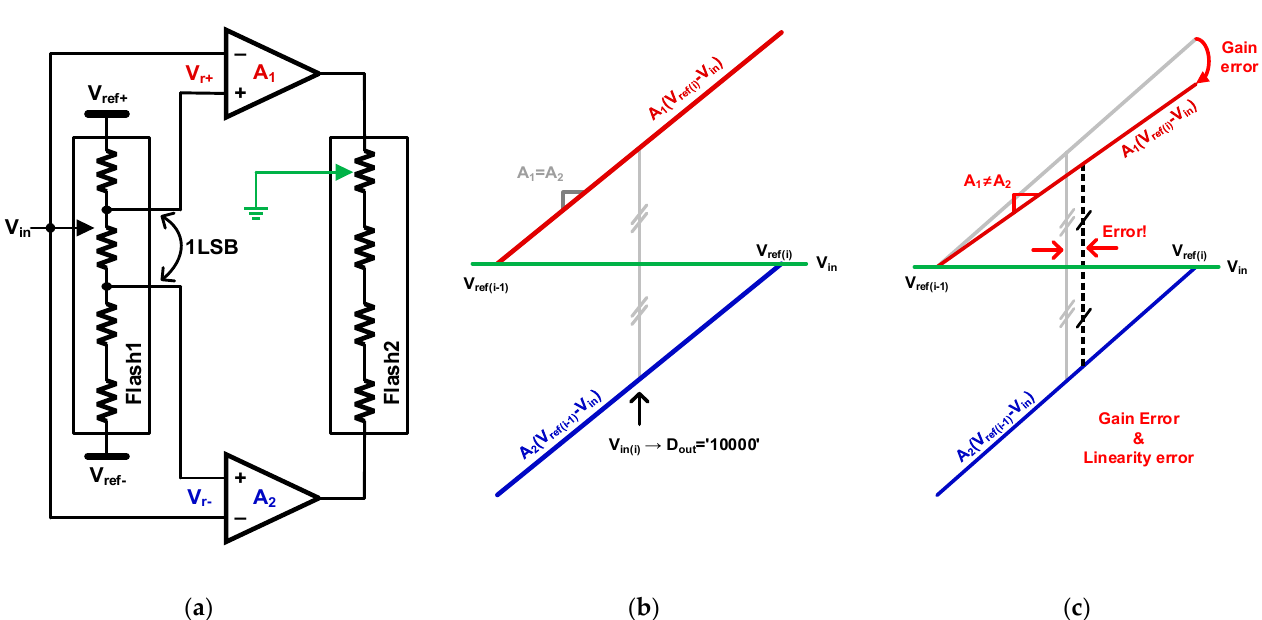
Figure 2. Dual-residue processing concepts: ( a ) Block diagram from [19]; ( b ) Residue profile with matched gain; ( c ) Residue profile with mismatched gain.